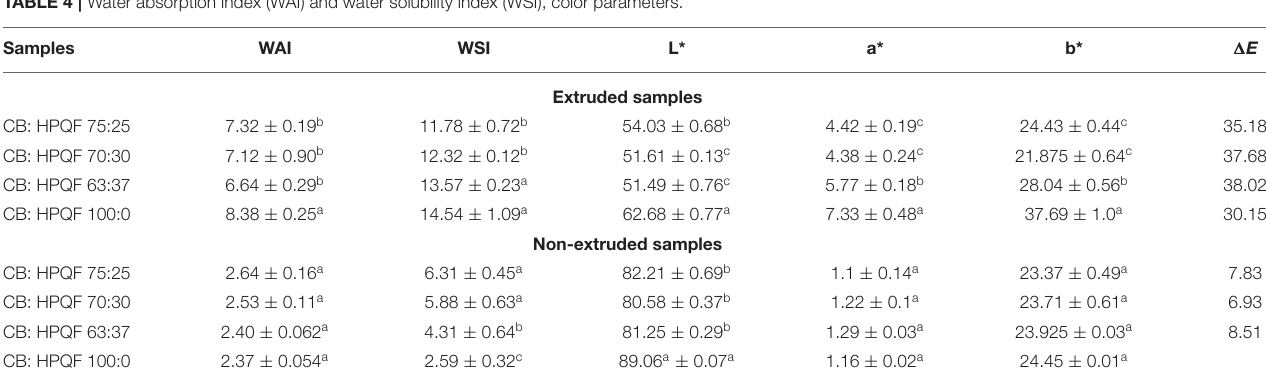
TABLE 4 | Water absorption index (WAI) and water solubility index (WSI), color parameters.